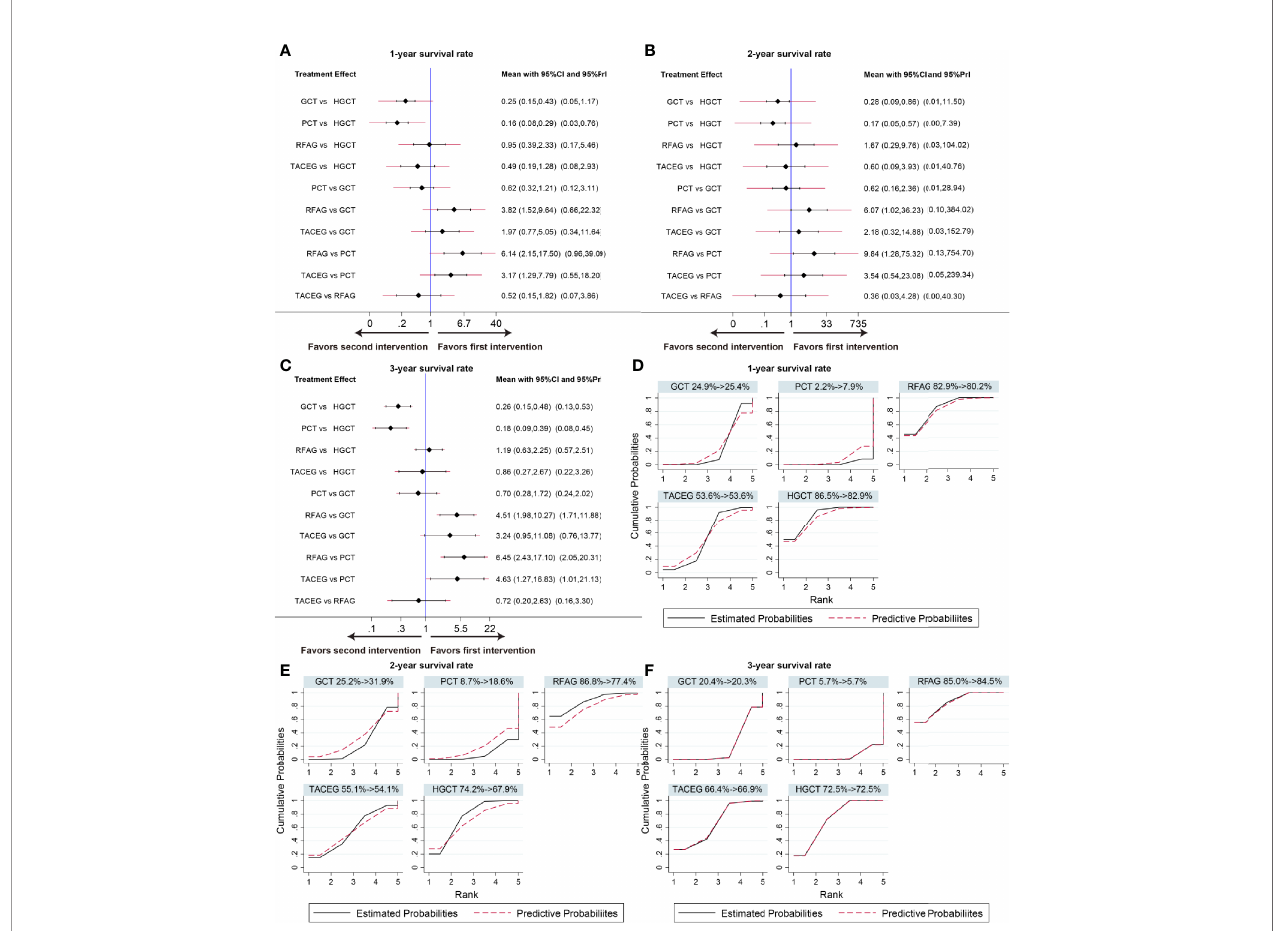
FIGURE 6 | Con fi dence interval plot and SUCRA for the network analysis in the Asian population. The black and red solid lines represent the 95% con fi dence interval and the predictive intervals for summary relative risks for each comparison in the con fi dence interval plot. The blue line is the line of no effect (relative risk equal to 1). Con fi dence interval plot of 1-, 2- and 3- year survival rate in the Asian population (A – C) . SUCRA of 1-, 2- and 3- year survival rate (D-F) in the Asian population. Black solid lines correspond to the unadjusted model and red dashed lines to the adjusted for small effects model. Ranking indicates the probability to be the best treatment.